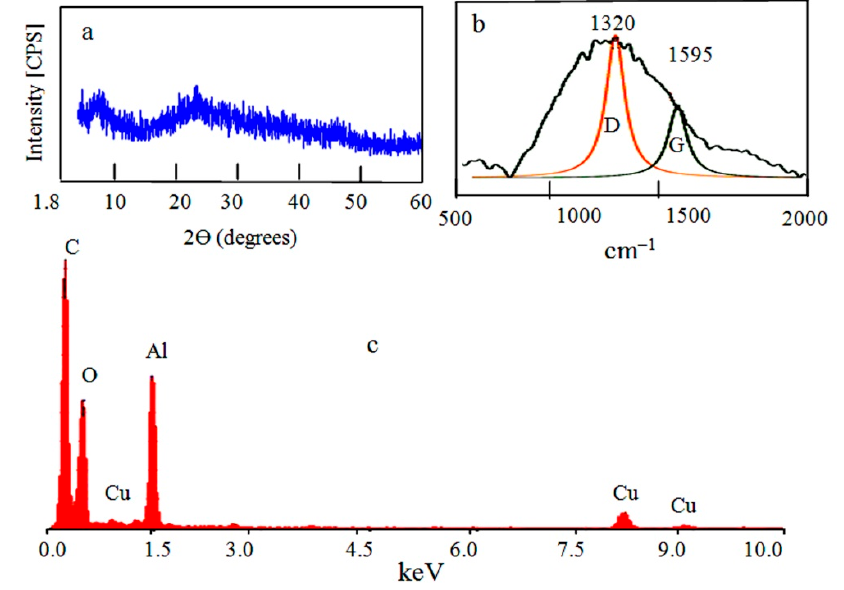
Figure 4. The prepared nanocomposite NC-2: ( a ) X-ray diffraction, ( b ) Raman spectrum, and ( c ) EDX analysis.